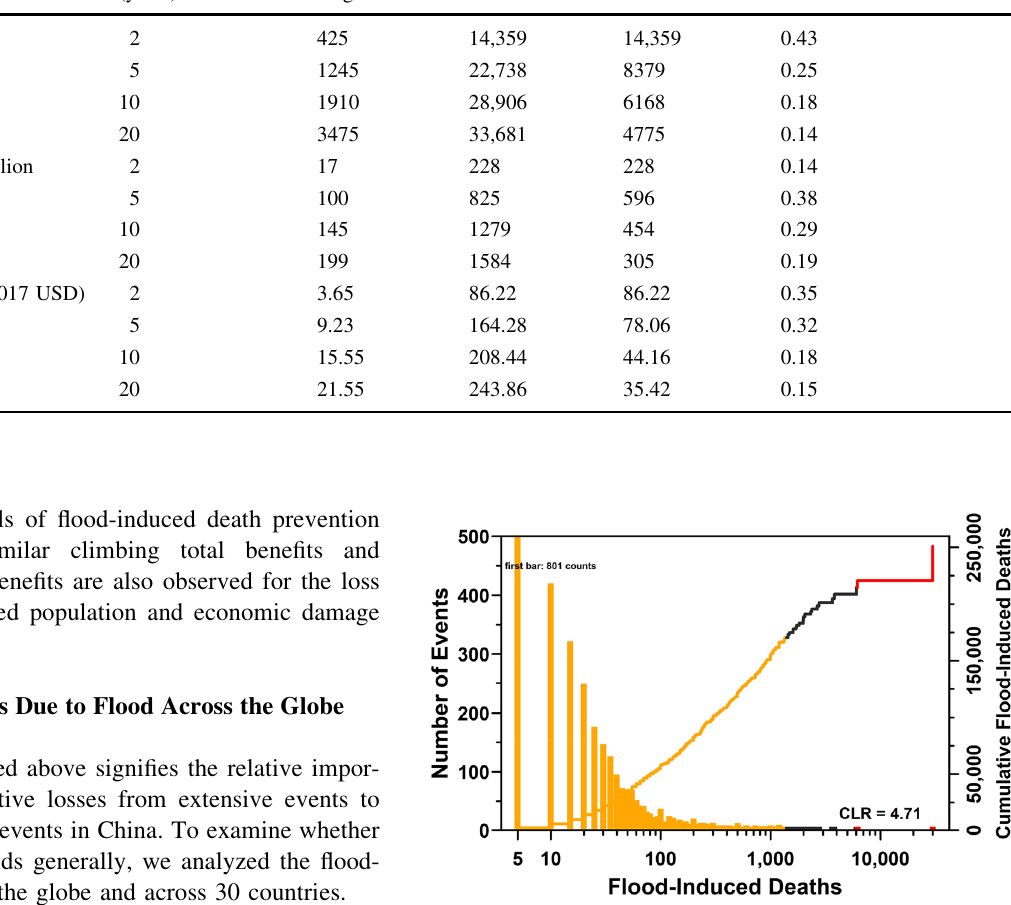
Fig. 2 Cumulative loss plot showing the distribution of global flood- induced deaths for the period 1976–2016 (based on the EM-DAT data). Explanations for Fig. 2 categories are similar to those found in Fig.